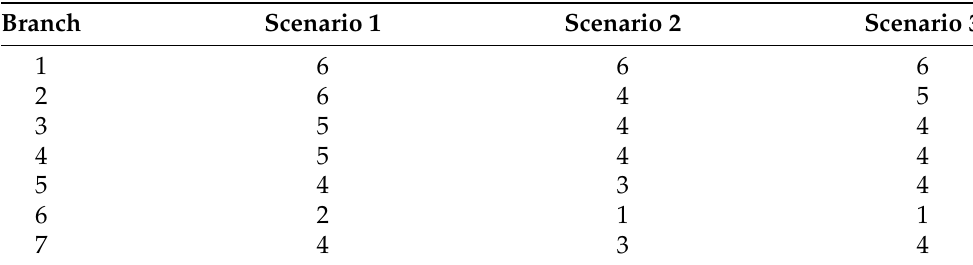
Table 13. Calibers selected for the 8-bus system in the balanced load